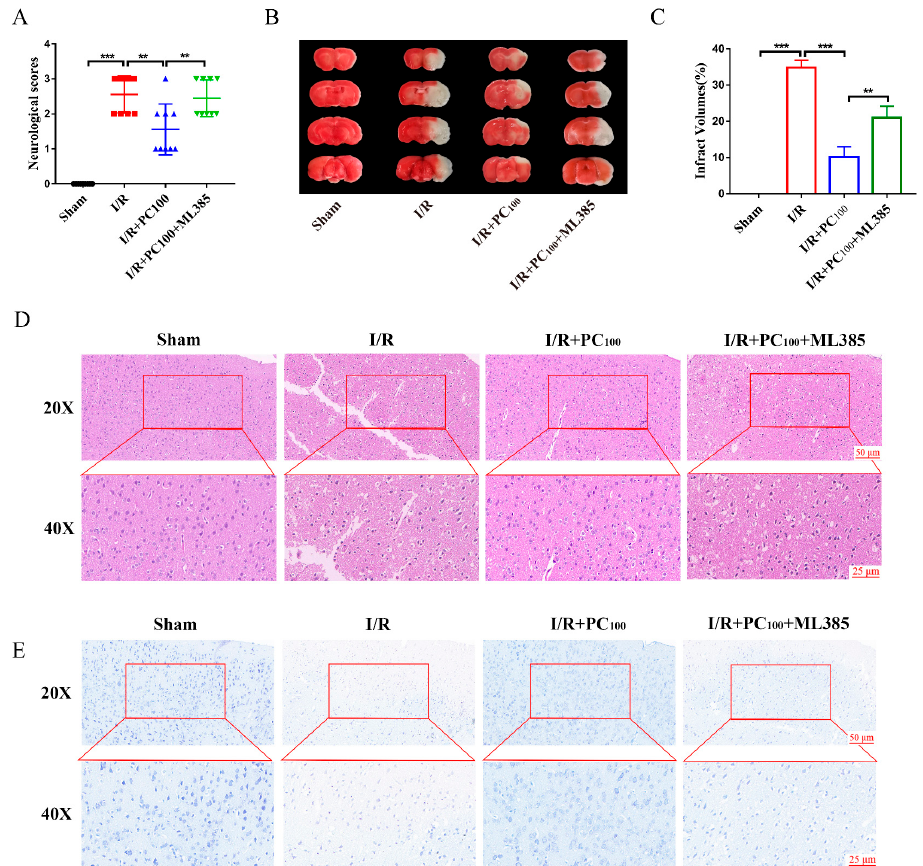
Figure 5. ML385 reversed the neuroprotective effect of procyanidins. ( A ) Neurological scores of mice with CIRI. ( B , C ) The cerebral infarct volume in mice after CIRI (n = 6). ( D ) Representative HE − stained sections of the mouse cortex. ( E ) Representative Nissl-stained sections of the mouse cortex. All values are expressed as mean ± SD. n.s: no significant difference, ** p < 0.01, *** p <